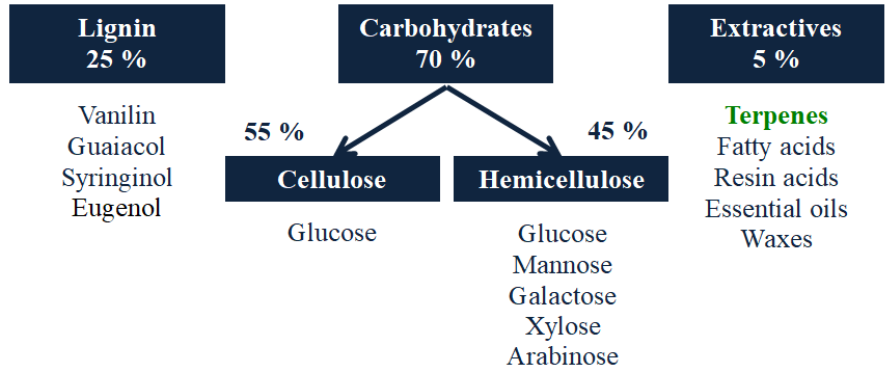
Figure 2. Presence of terpenes in lignocellulosic biomass.